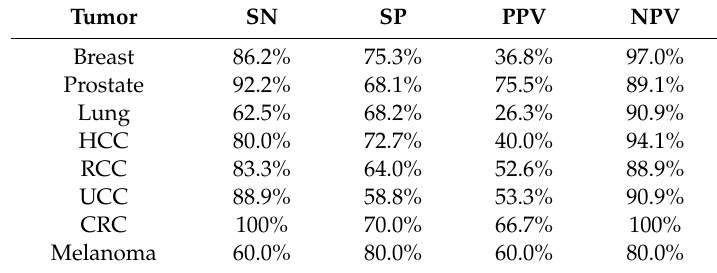
Table 2. Performance of the BSI as a diagnostic test for bone metastases. Descriptive statistical parameters refer to the decision-making when zero / non-zero BSI is used to distinguish between M0 and M1. A BSI larger than zero indicates osseous involvement according to its actual definition.